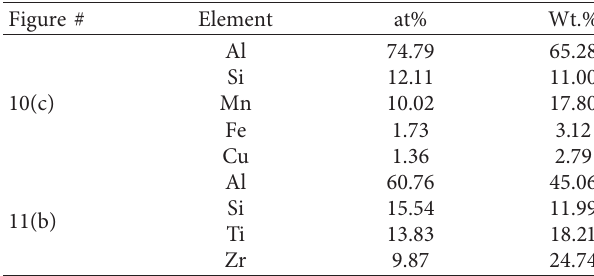
Table 3: Chemical compositions of phases corresponding to EDS spectra reported in the present